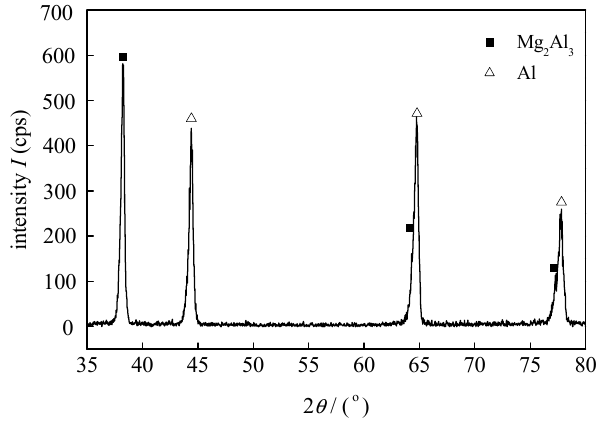
Figure 12. XRD analysis of weld zone.